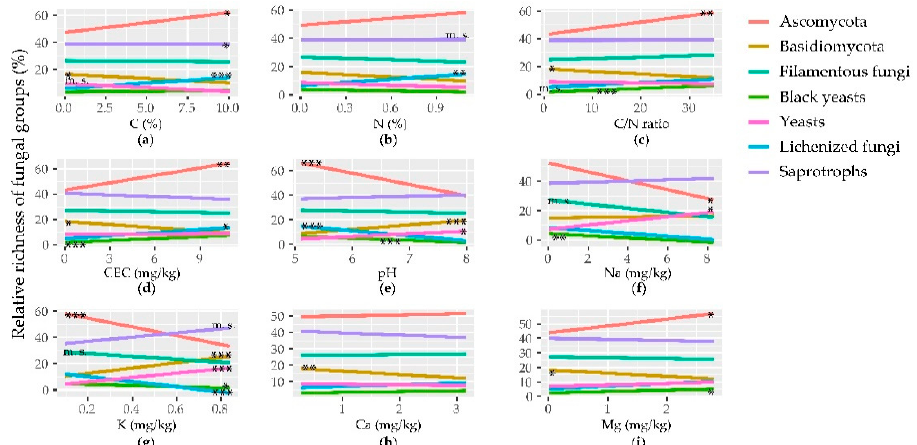
Figure 5. Regression lines for the variation of relative richness ( y -axis) of the two dominant phyla, the growth forms, and the functional guilds in response to soil chemical parameters. The different panels report the correlations with: ( a ) C; ( b ) N; ( c ) C/N ratio; ( d ) cation exchange capacity (CEC); ( e ) pH; and exchangeable ( f ) Na, ( g ) K, ( h ) Ca, and ( i ) Mg ( x -axis). The significance of the regressions is indicated as *** p < 0.001, ** p < 0.01, * p < 0.05, m. s. (marginally significant) p < 0.1. Slopes and r 2 values of the regressions are reported in Table S1.